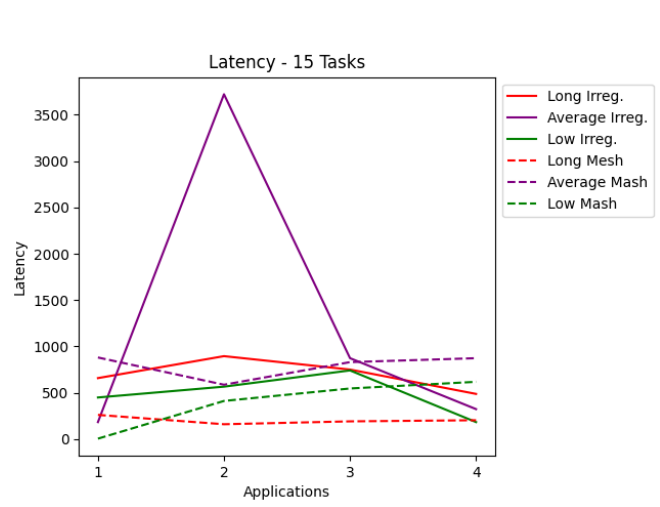
Figure 8. Latency for applications with 15